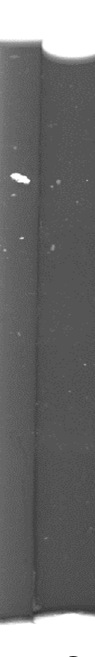
Figure 1. Cross section of a 3D-XRM images of a composite containing 10% BST and 15% NZF. The composite contains some conglomerations (<1 mm in width) of BST, but the dispersion is good over- all.